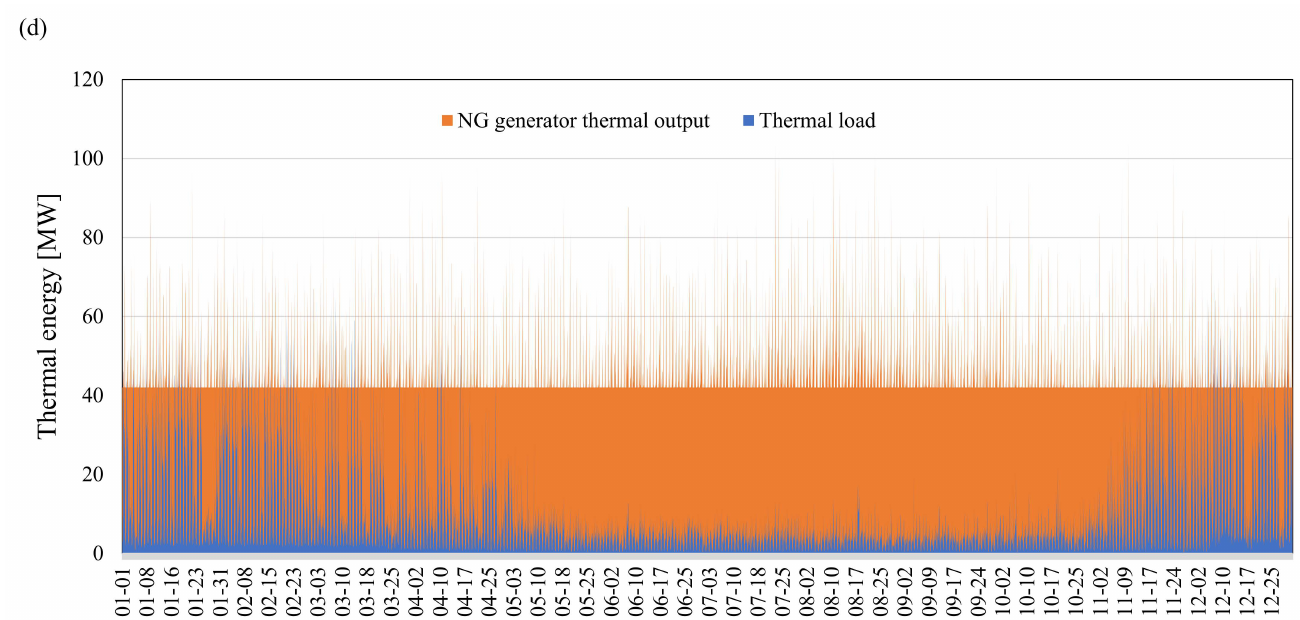
Figure 6. Operating profile of NG generator in the base case: ( a ) monthly electricity balance, ( b ) monthly thermal balance, ( c ) hourly electricity balance, ( d ) hourly thermal